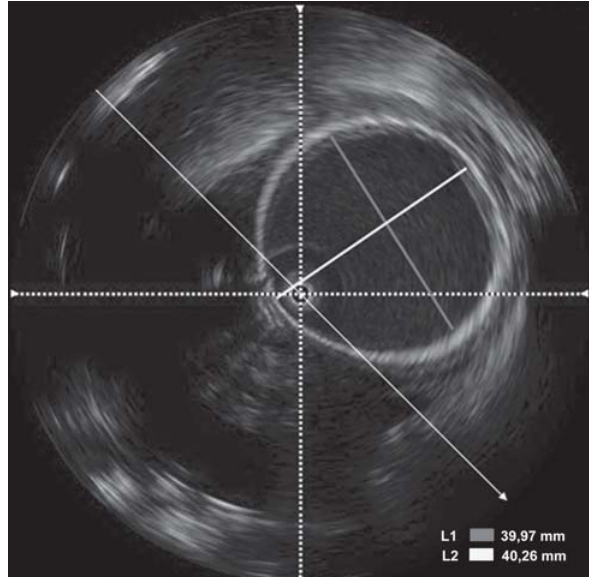
Fig. 4 - Ultrassom intravascular em paciente (n o 5) submetido à troca de segmento de aorta ascendente por prótese de dacron, a qual se destina como zona de ancoragem proximal de endoprótese. Apesar de o diâmetro nominal da prótese utilizada ser de 34mm,